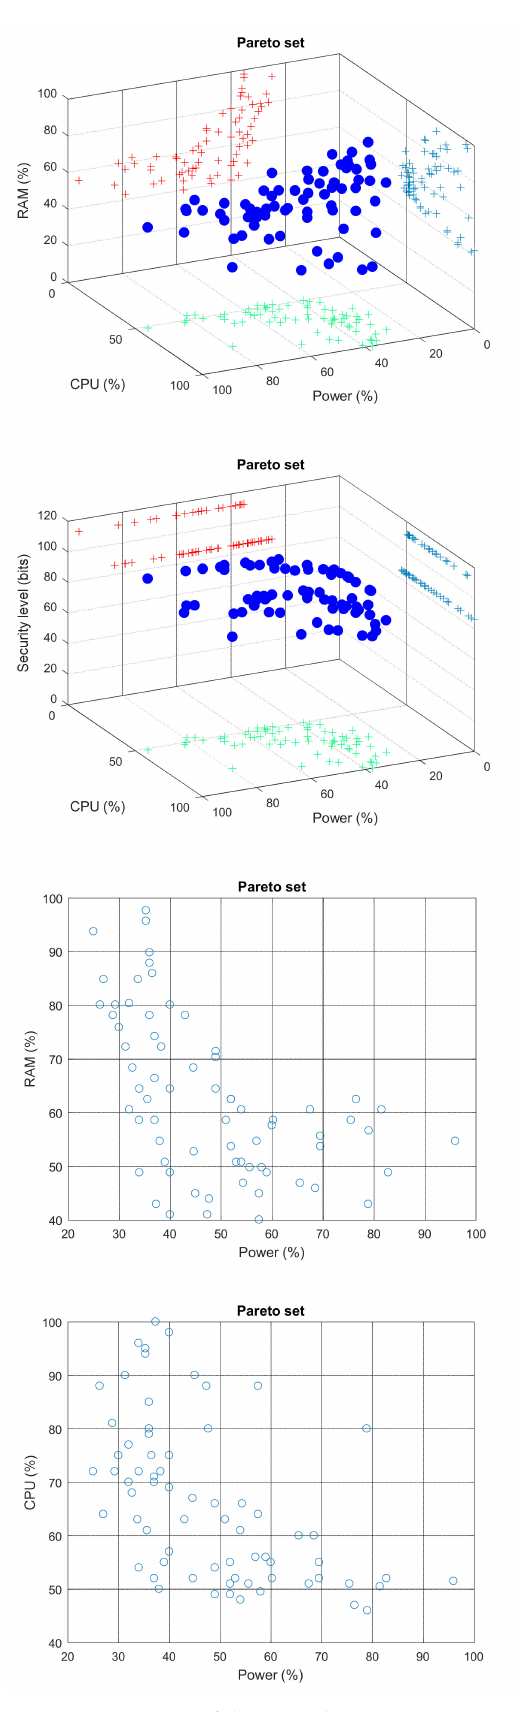
Figure 9. Pareto set of the second scenario, security and energy are